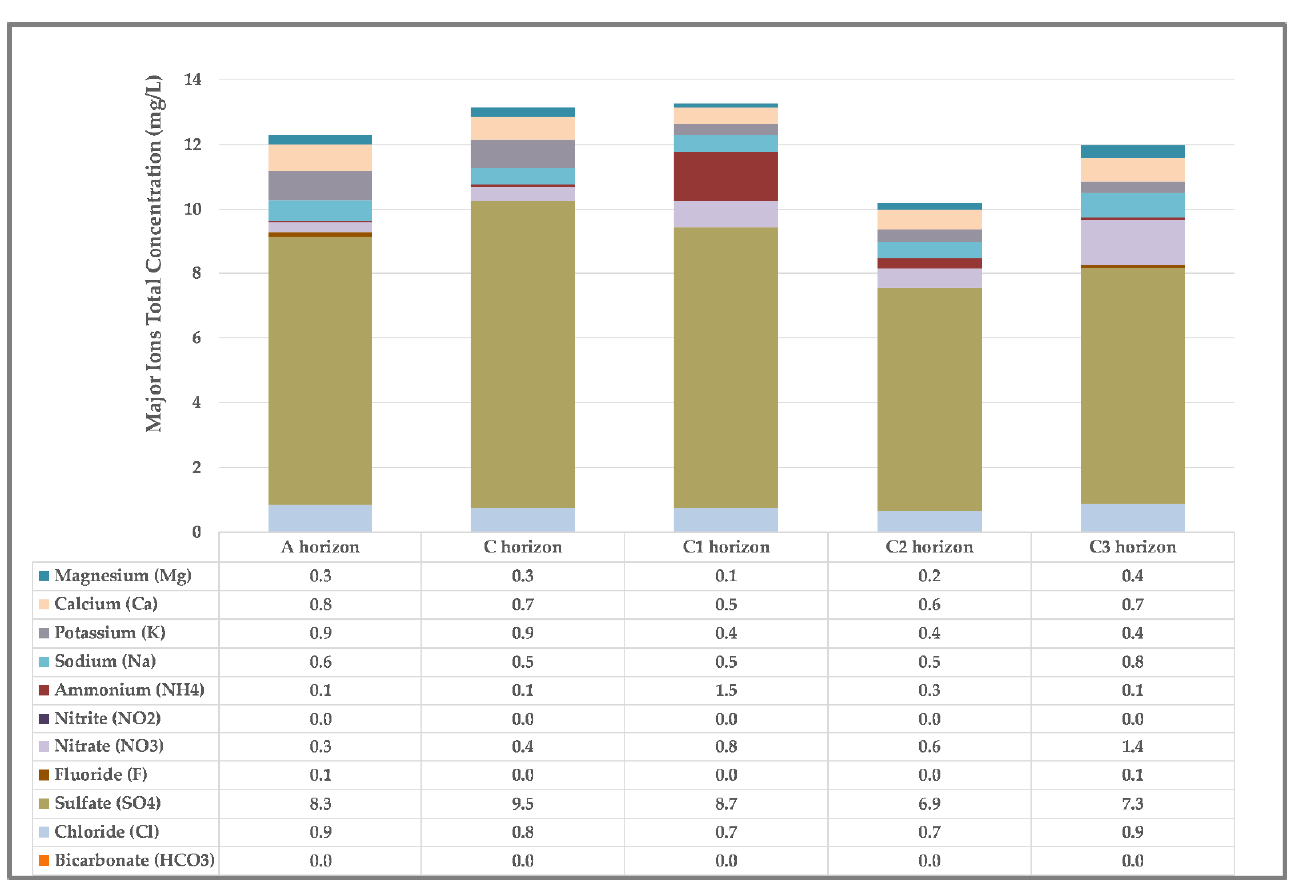
Figure 5. Concentration of major ions in soil leachates from São Pedro da Cova mine waste pile.